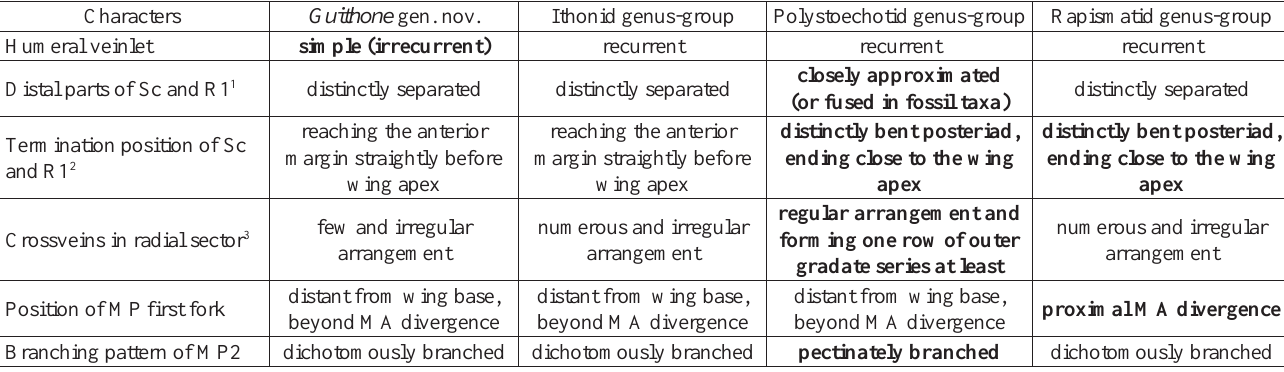
Table 1. Comparisons of Guithone gen. nov. with three lineages of Ithonidae. Putatively apomorphic states in bold. 1 Separated Sc and R1 occurs in all extant ithonid genus-group and most rapismatid genus-group (unknown in Principiala ). In polystoechtid genus-group, the extant genera also have the separated Sc and R1, but Sc and R1 are distinctly approximated distad in fossil polystoechotid genus-group (e.g., Palaeopsychops Andersen, 2001) that is different to the other groups. 2 Sc and R1 in ithonid genus-group commonly straightly (or slightly bent) reach the anterior margin, however, Sc and R1 in the other groups distinctly incline posteriad and ending close to wing apex. 3 Regular arrangement of crossveins in radial sector occurs in extant giant genus-group. Although some Eocene giant genus-group also show the complicated crossvenation, these species generally possess one row of outer gradate series at least. Contrarily, crossveins in radial sector in the other groups are always numerous and irregularly arranged. Few and irregular crossveins as a particular state are only found in some fossil taxa, e.g., Guithone gen. nov., Lasiosmylus Ren and Guo, 1996, Paleopterocalla (Panfilov, 1980), Panfilovdvia (Panfilov,